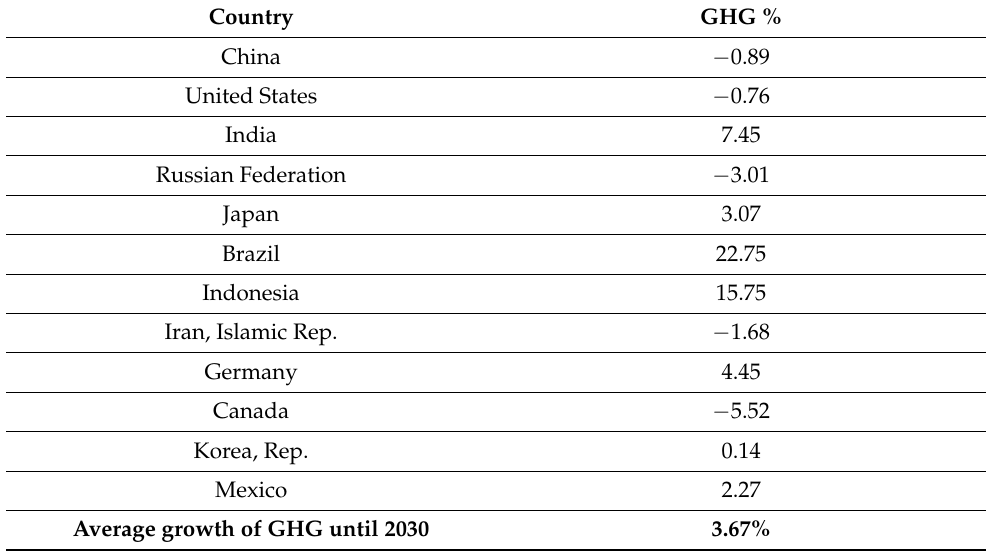
Table 7. Predicted change in GHG emissions in top polluting countries over